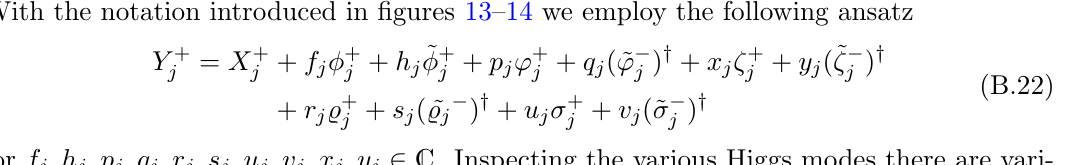
(e) Con(cid:12)guration 12a (f) Con(cid:12)guration 12e Figure 32. C [( N 1 ; 0)] + C [( N 2 ; 0)] + C [( N 3 ; 0)] with Higgs con(cid:12)guration as in (cid:12)gure 12a or 12e, respectively. The number of negative modes of O X + (cid:30) , for each choice of mass value M , are depicted V in (a) and (b). The red dashed vertical lines indicates the mass value M (cid:3) . In addition, we provide the number of bosonic zero modes in (c), (d) and the number of fermionic zero modes in (e), (f). C [( N ; 0)] + C [( N ; 0)] with N > 1 shows 42 zero modes, which are 3 (cid:1) 14 originating from 2 3 i independent copies of C [( N ; 0)] plus maximal i